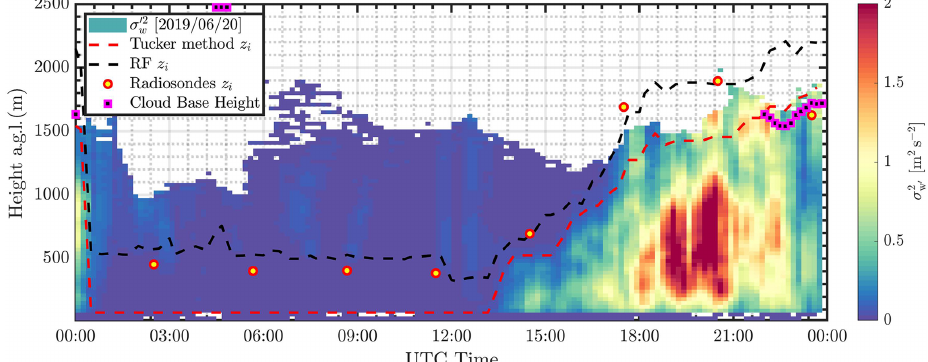
Figure 6. Boundary layer height estimates at the SGP central facility on 20 June 2019 from the Tucker method (Tucker et al., 2009), RF model z i , radiosondes z i (Sivaraman et al., 2013), cloud base height estimates from lidar (Newsom et al., 2019b), and the background colours represent vertical velocity variance measurements from Doppler lidar.